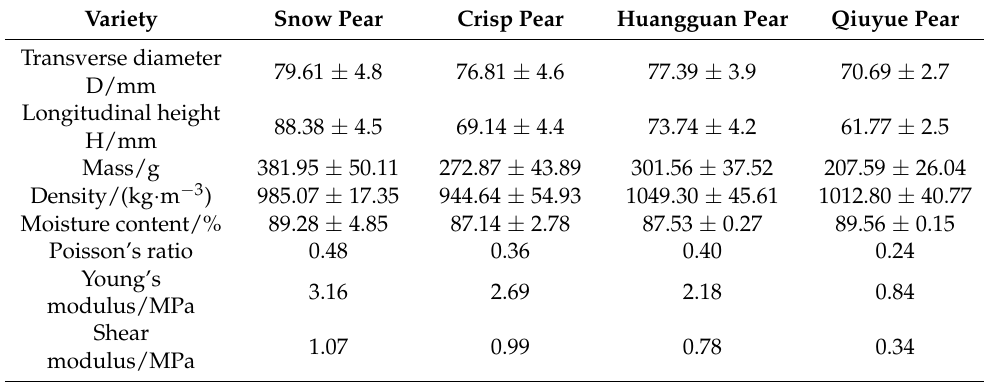
Table 1. Intrinsic parameters of typical pears.